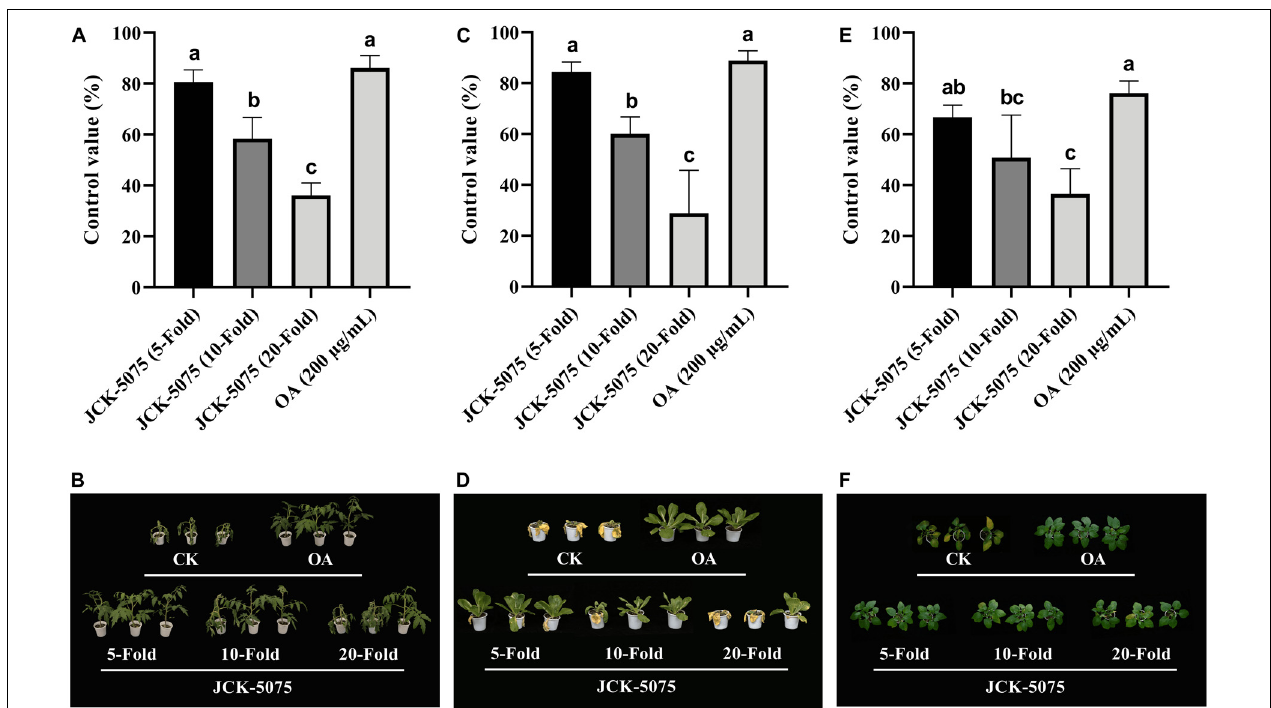
FIGURE 1 | The biocontrol efficacy of the fermentation broth of Paenibacillus elgii JCK-5075 on tomato bacterial wilt (A,B) , Kimchi cabbage bacterial soft rot (C,D) , and red pepper bacterial leaf spot diseases (E,F) . Each value represents the mean ± standard deviation ( n = 3) of two runs, with three replicates each. Means followed by the same letters above the bars are not significantly different ( p < 0.05) in a Duncan’s multiple range test. JCK-5075 ( 5-, 10-, and 20-fold) are 5-, 10-, and 20-fold dilutions of the fermentation broth of JCK-5075; OA, oxolinic acid (200 µ g/ml).